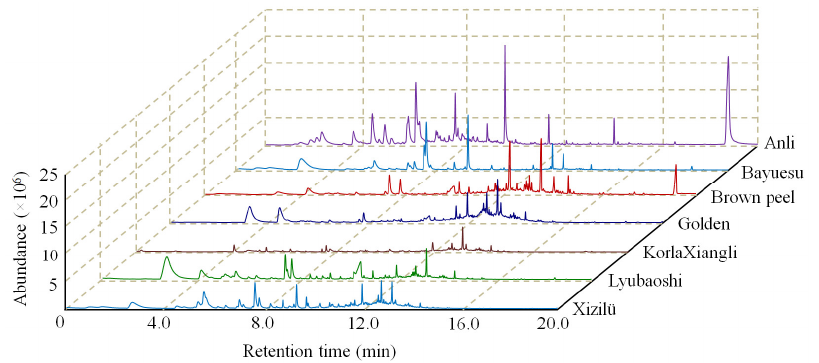
Figure 1. Chromatographic profiles obtained by SPME-GC-MS of volatile compounds in pear flower of seven cultivars.